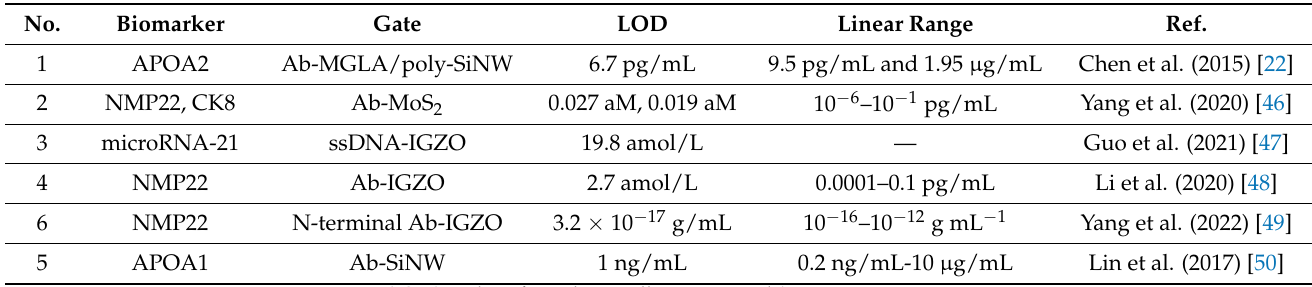
Table 3. Summary of the field-effect transistor-based sensor for bladder cancer urine biomarker